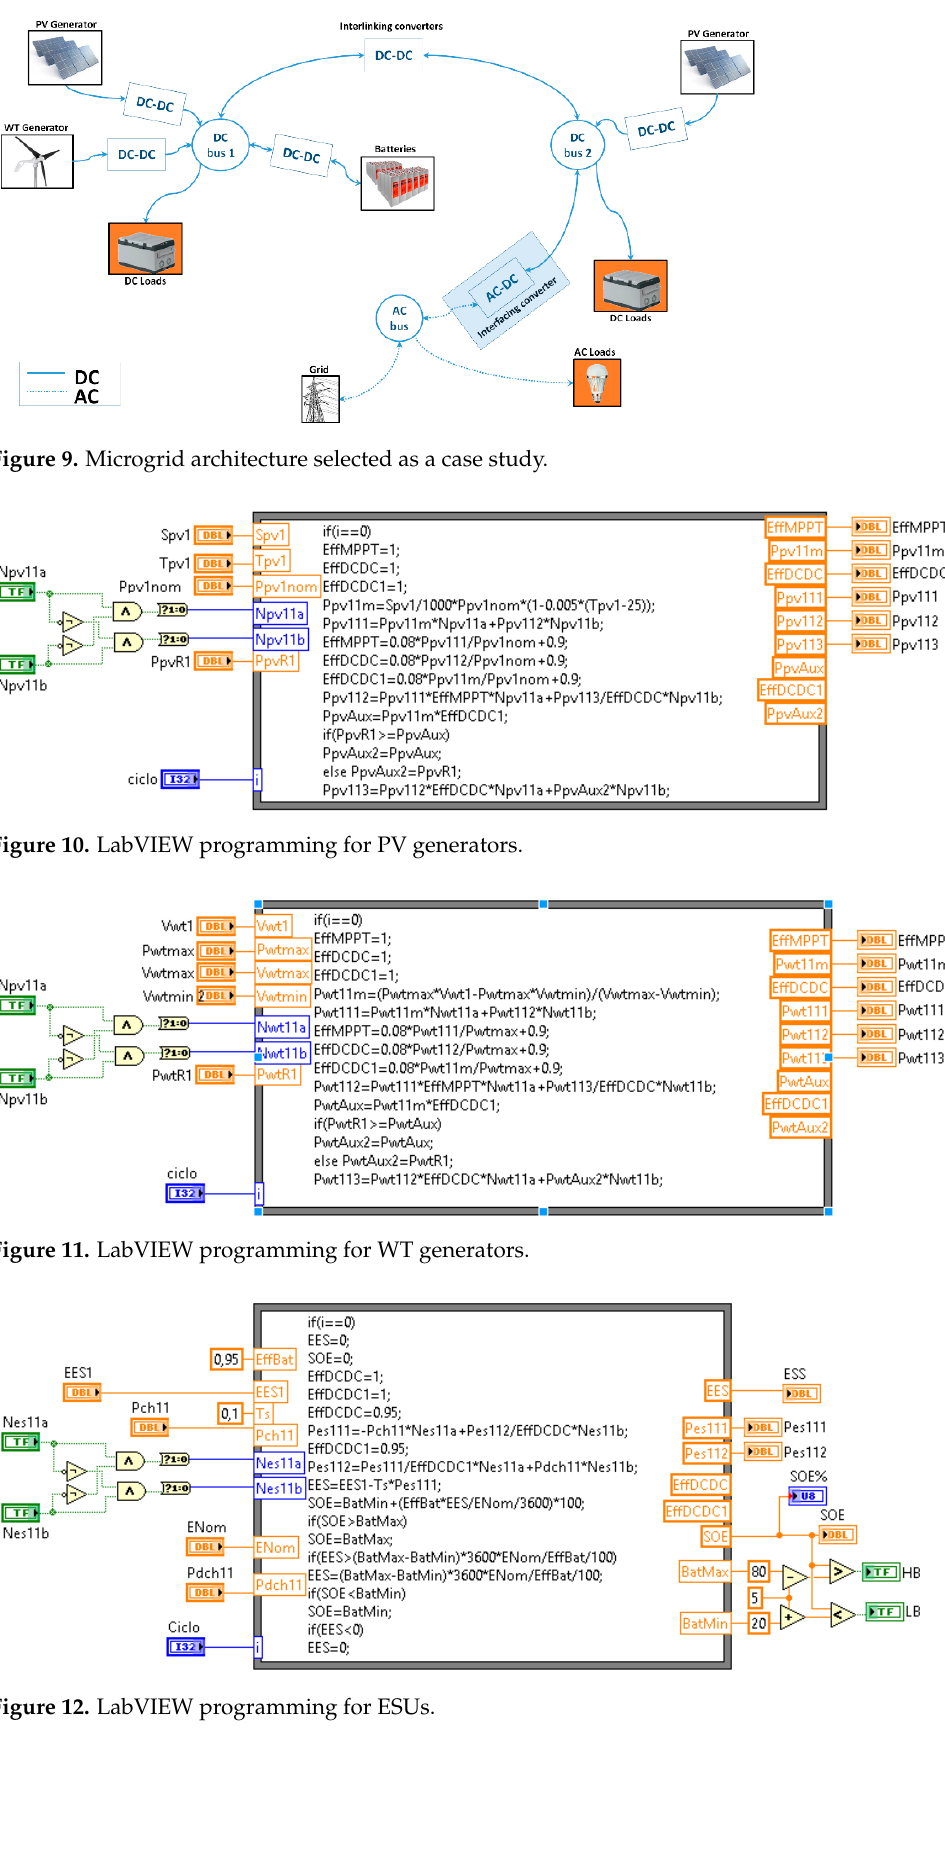
Figure 13. LabVIEW programming for ILCs.